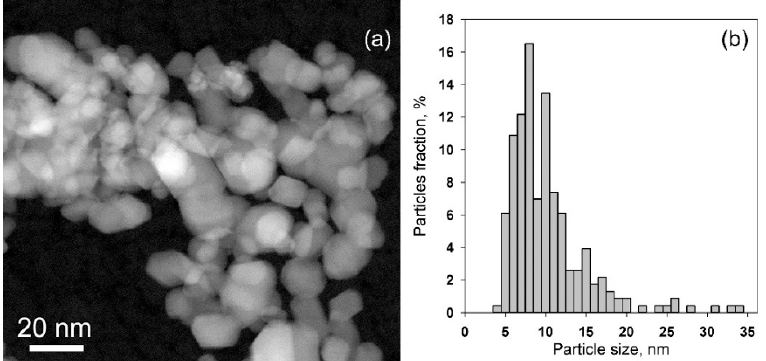
Figure 4. High angle annular dark field scanning transmission electron microscopy (HAADF-STEM) image: ( a ) and particle size distribution ( b ) of the SnO 2 matrix.